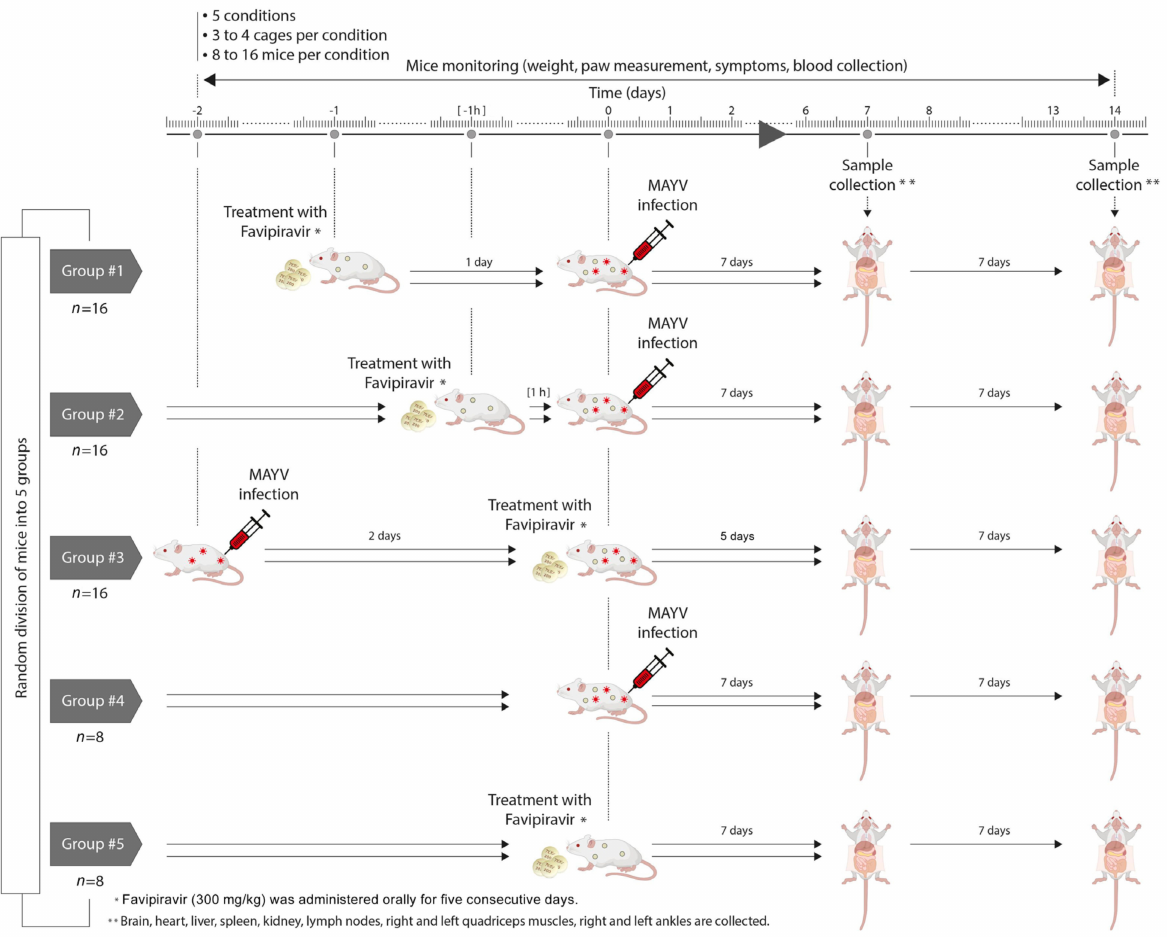
Figure 1. Schematic representation of the experimental